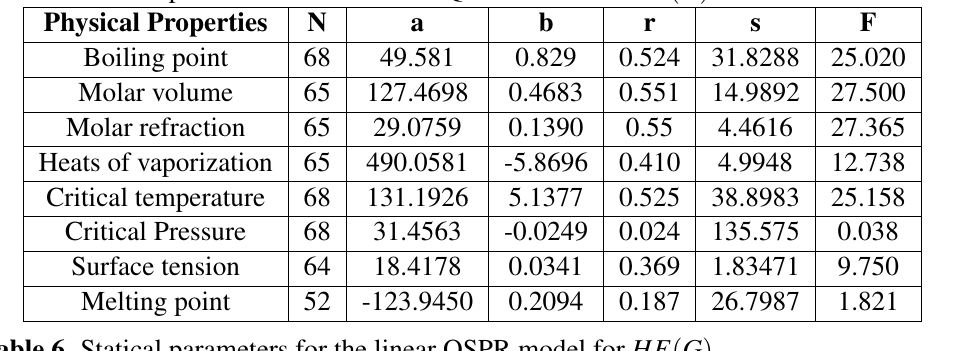
Table 5. Statical parameters for the linear QSPR model for FE ( G ) .